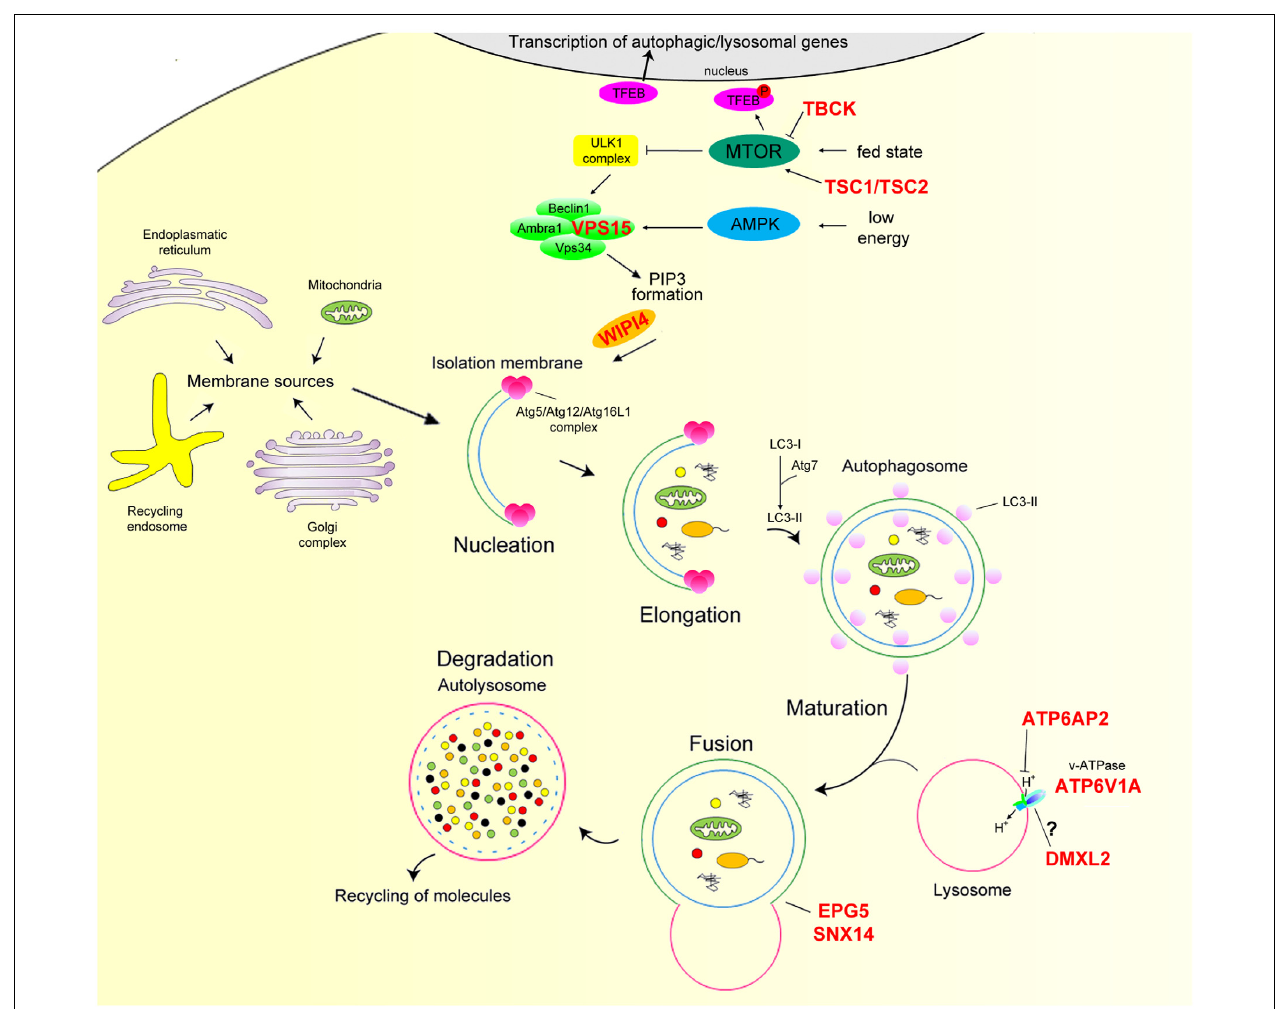
FIGURE 1 | Overview of the mammalian autophagy pathway. In nutrient-rich conditions (fed state) mTOR phosphorylates TFEB preventing its nuclear translocation. In nutrient depletion or low-energy state, mTOR is inactive, and TFEB translocates to the nucleus leading to the transcription of many autophagy and lysosomal genes. mTOR inhibition together with AMPK activation positively regulate the ULK1 complex. Induction of this complex regulates the recruitment of the Beclin1/Ambta1/VSP34/VPS15 complex to the phagophore and, hence, the production of PI3P and downstream autophagy effectors Atg5/Atg12/Atg16L1 via the binding of WIPI proteins. This step is essential for the conversion of LC3-I to LC3-II through Atg7 and its conjugation to phagophore membrane. The membranes of these structures appear to have multiple sources, such as the endoplasmic reticulum, Golgi apparatus and trans-Golgi network, endosomal compartment, and mitochondria. LC3-II attracts components of the autophagy machinery and is required for elongation and closure of the phagophore membrane. Mature autophagosome finally fuses with the lysosome, forming the autolysosome, where autophagic cargo is degraded and then released back to the cytoplasm to be re-used by the cell. The proton gradient imposed by the lysosomal v-ATPase is essential for proteolysis as hydrolase activity strictly relies on acidic pH. Autophagy genes mutated in neurodevelopmental disorders with epilepsy are marked in red. AMPK, AMP-dependent protein kinase; mTORC1, mammalian target of rapamycin complex 1; TFEB, transcription factor EB; ULK, mammalian homologs of the Caenorhabditis elegans uncoordinated-51